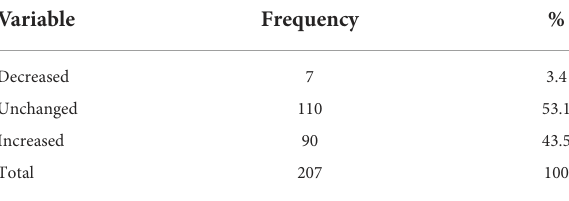
TABLE 7 Summary statistics of food stored at home.